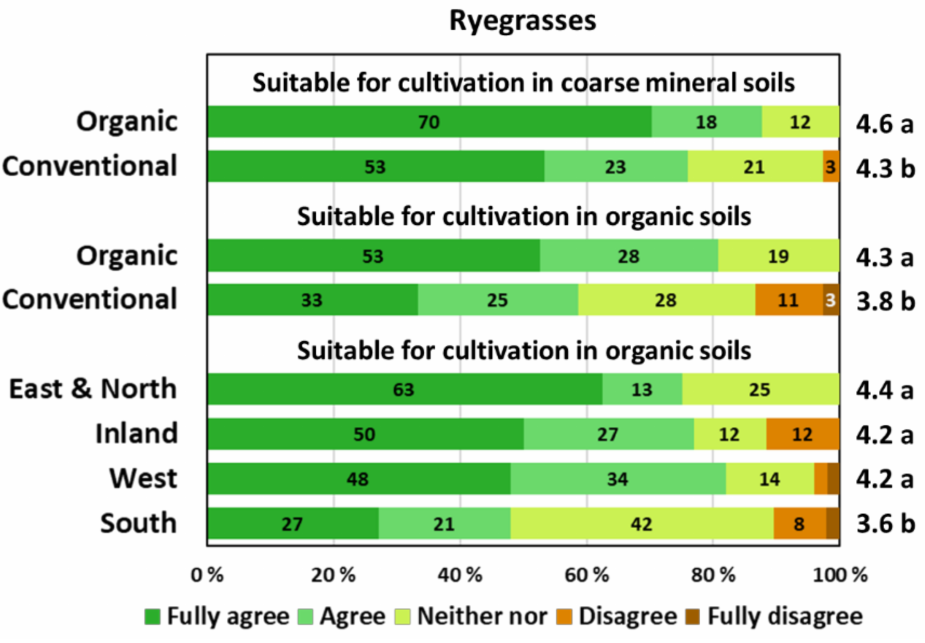
Figure 5. The distribution and mean of farmers’ experience-based answers to the statements about suitability of under-sown ryegrasses for different soil types depending on farming system and region. Only significant differences are shown. The answer choices were: 1 = fully disagree, 2 = disagree, 3 = neither agree nor disagree, 4 = agree, and 5 = fully agree. Means with the same letter for each statement and farm characteristic do not differ